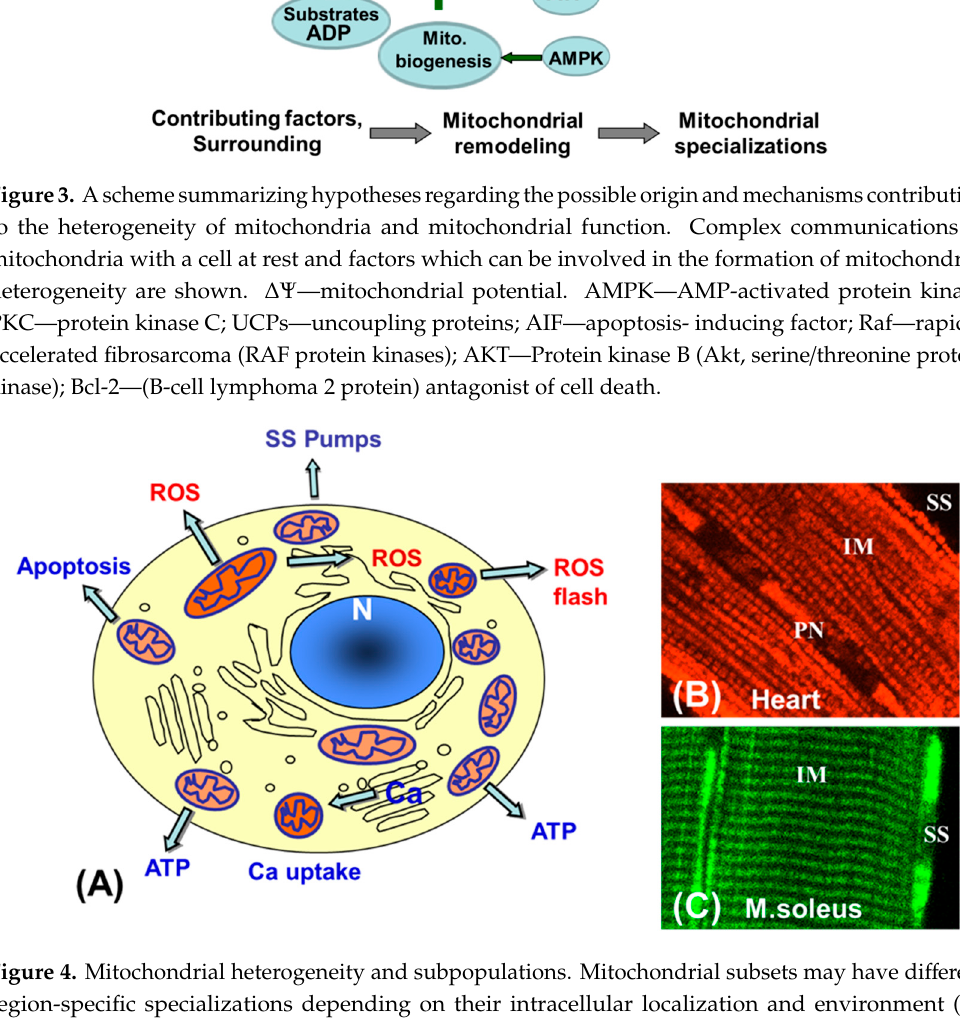
Figure 3. A scheme summarizing hypotheses regarding the possible origin and mechanisms contributing to the heterogeneity of mitochondria and mitochondrial function. Complex communications of mitochondria with a cell at rest and factors which can be involved in the formation of mitochondrial heterogeneity are shown. ΔΨ —mitochondrial potential. AMPK—AMP-activated protein kinase; PKC—protein kinase C; UCPs—uncoupling proteins; AIF—apoptosis- inducing factor; Raf—rapidly accelerated fibrosarcoma (RAF protein kinases); AKT—Protein kinase B (Akt, serine/threonine protein kinase); Bcl-2—(B-cell lymphoma 2 protein) antagonist of cell death.